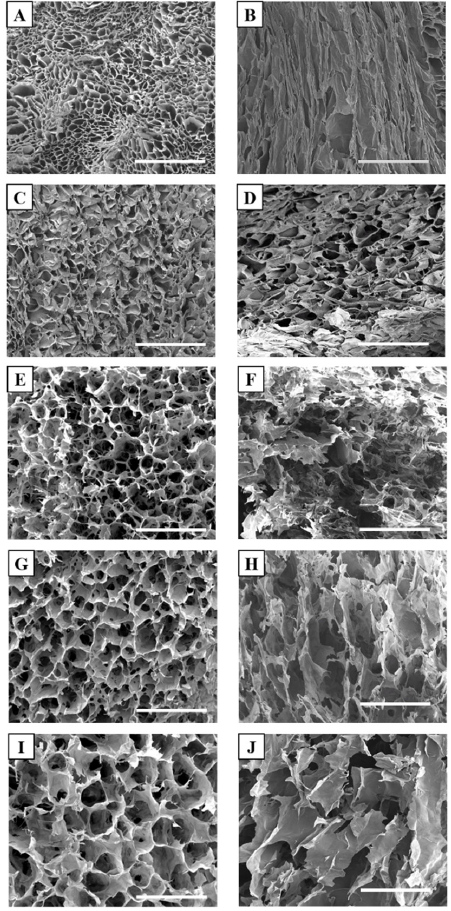
Figure 2. Cross- and sagittal-sectioned SEM images of ( A , B ) Gel; ( C , D ) CNFs; ( E , F ) GCN(Gel:CNFs)- 75:25; ( G , H ) GCN-50:50; ( I , J ) GCN-25:75, all cross-linked by dehydrothermal treatment (DHT). Scale bars are 500 µm.